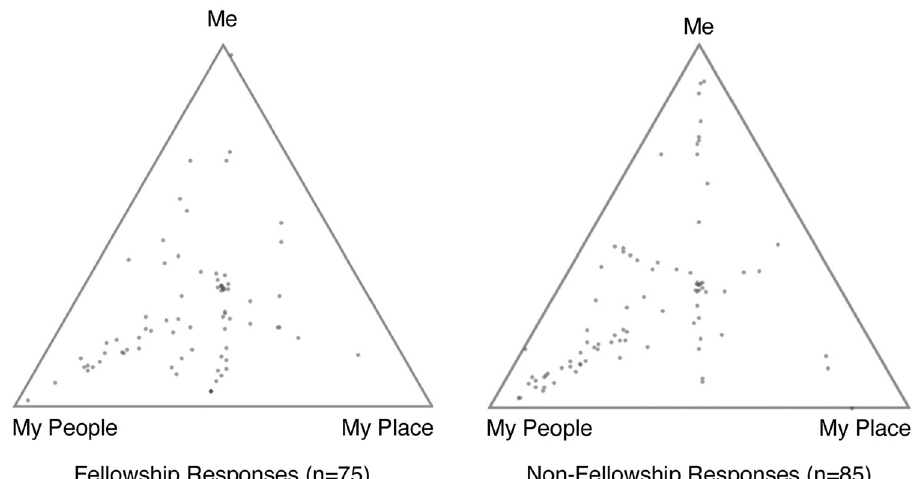
Fig. 3 Responses for Triad 1: